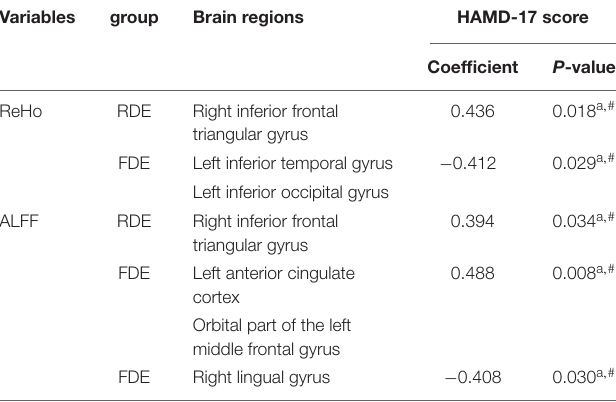
TABLE 4 | Correlation of abnormal brain areas with clinical